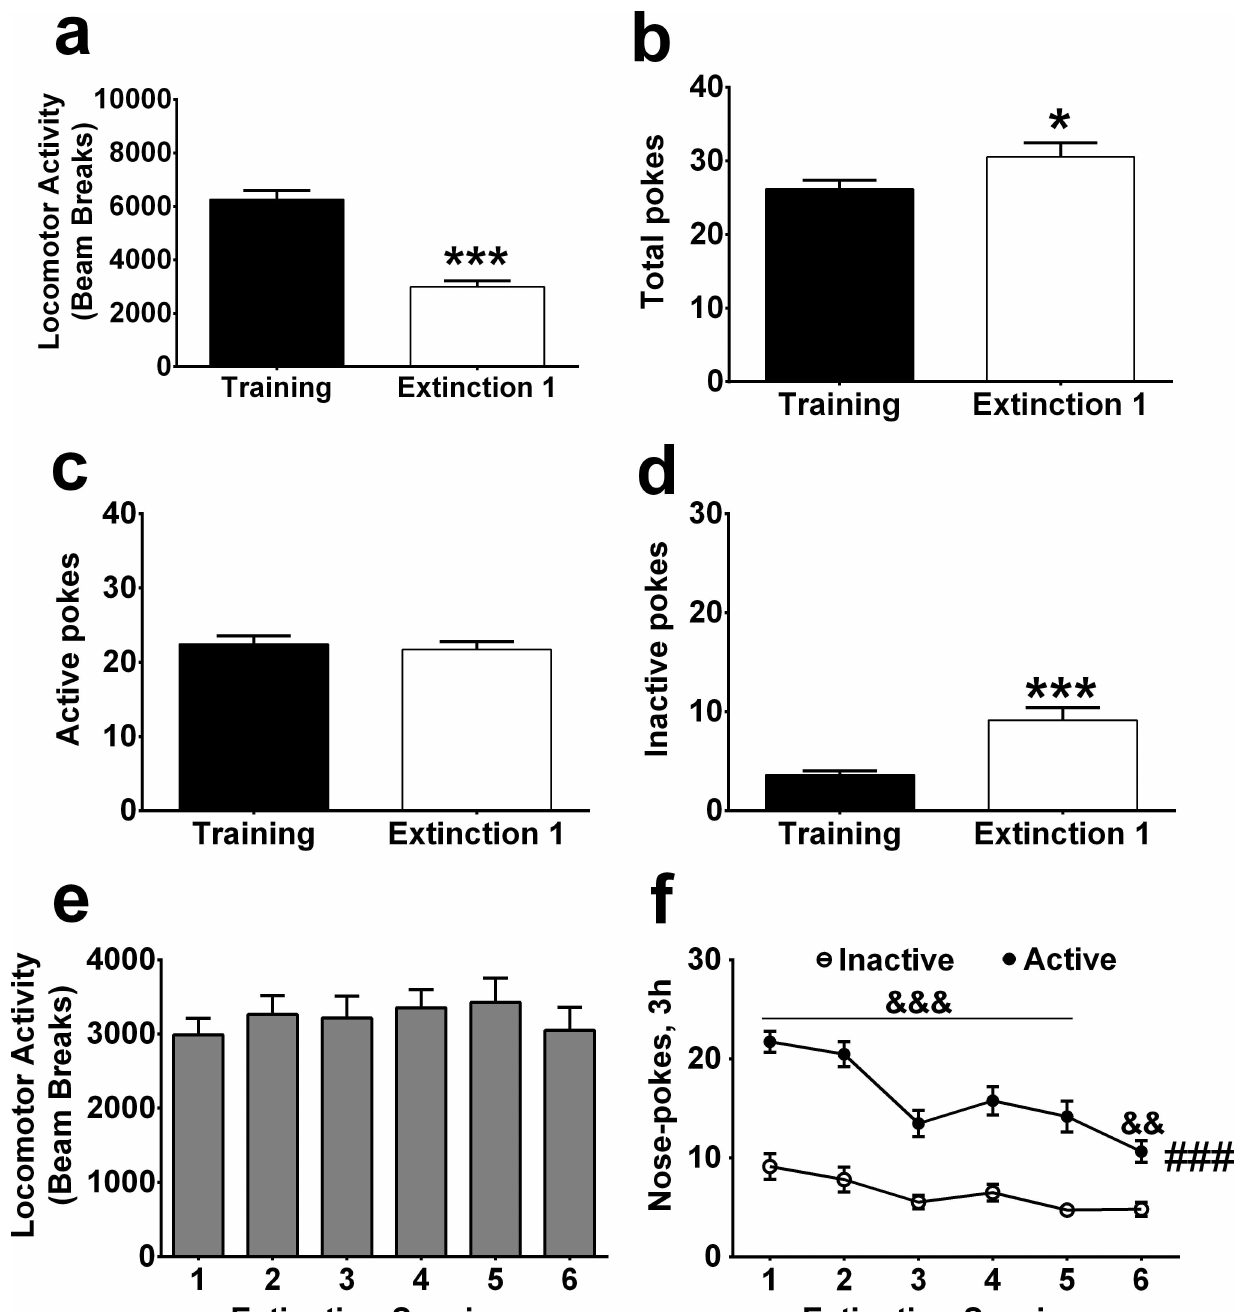
Fig 4. The locomotor activity decreasedin the first extinction session. (a) Comparedwith the last acquisition, the locomotor activity decreasedin the first extinctionday (n = 47). (b) The active pokes did not significantlychange betweenthe first extinctionday and the last acquisitionday. (c) The inactive pokes significantly increasedin the first extinctionday comparedwith the last acquisitionday. (d) The total pokes significantly increasedin the first extinctionday comparedwith the last acquisitionday. (e) The locomotoractivity did not changein the first six extinctiondays. (f) The active pokes were significantly higherthan the inactive pokes in the first six extinctiondays. * p < 0.05, *** p < 0.001, comparedto the last acquisitionsession. ### p < 0.001, compared to the inactive pokes. && p < 0.01, &&& p < 0.001, post hoc test comparedto the inactive pokes on the same